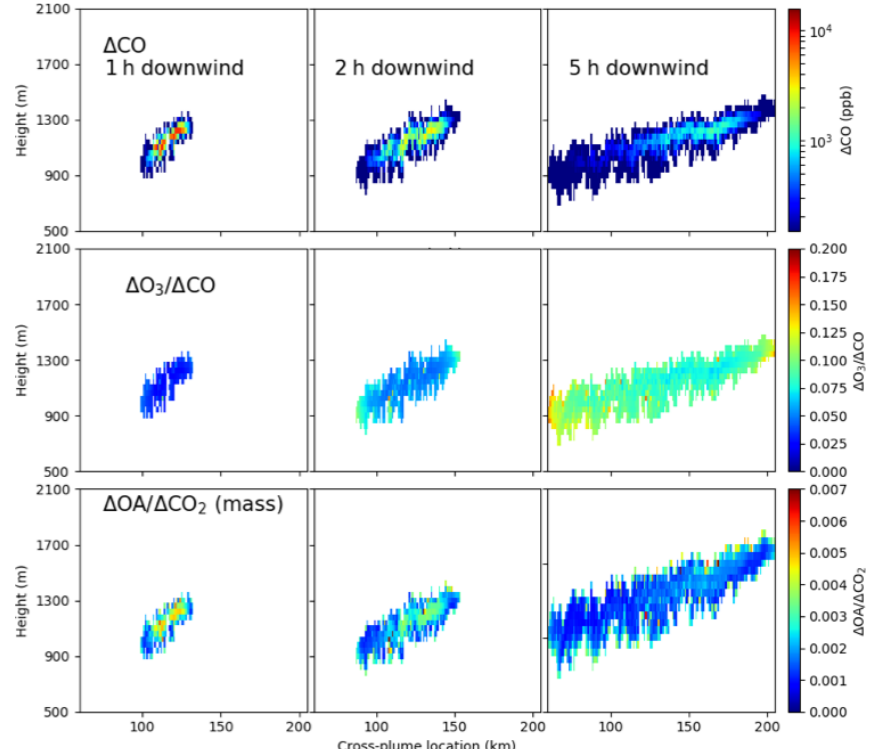
Figure 3. Height vs. cross-plume location at 1h (left column), 2h (center column) and 5h (right column) downwind of fire source for (cid:49) CO (top row), (cid:49) O 3 /(cid:49) CO (ppb/ppb, center row), and (cid:49) OA /(cid:49) CO 2 (bottom row). Note that figure is zoomed in on the plume, and white indicates a CO concentration of less than